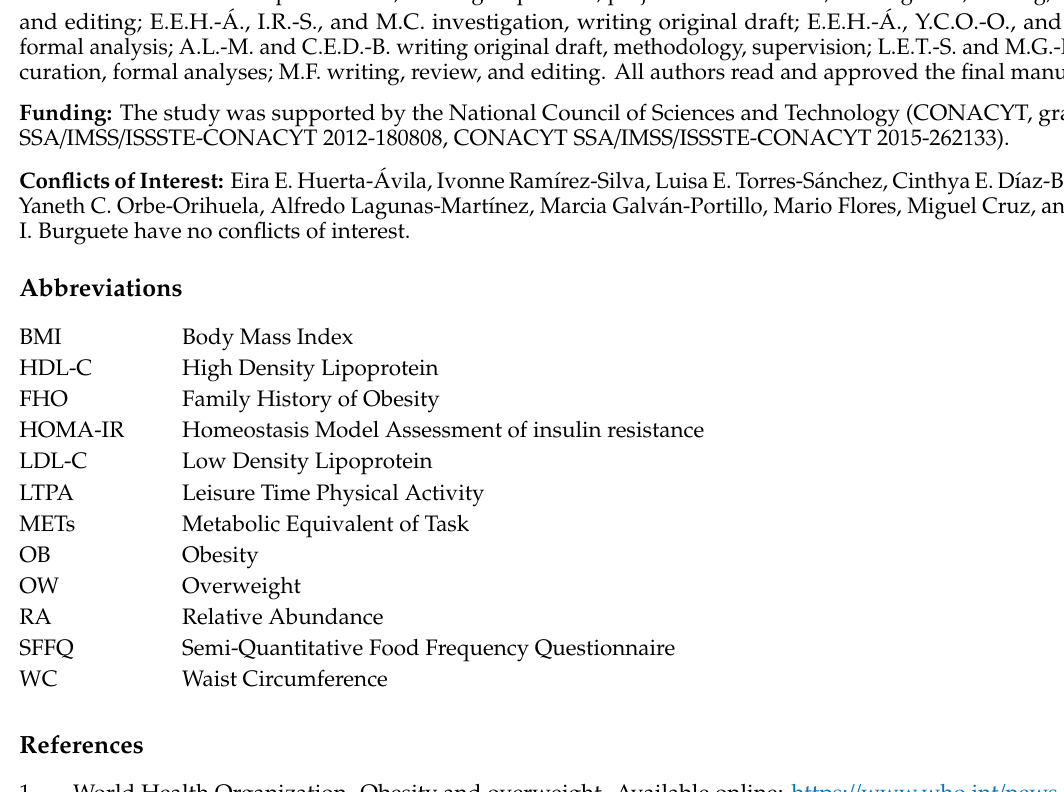
Figure S1: Path model of direct and indirect association between fructose intake tertiles and relative abundance of L. reuteri tertiles with adiposity and cardiometabolic markers in the cohort Mexican children. Table S1: Comparison of general characteristics of main analysis sample with information of the RA L. reuteri and Fructose intake and individuals without